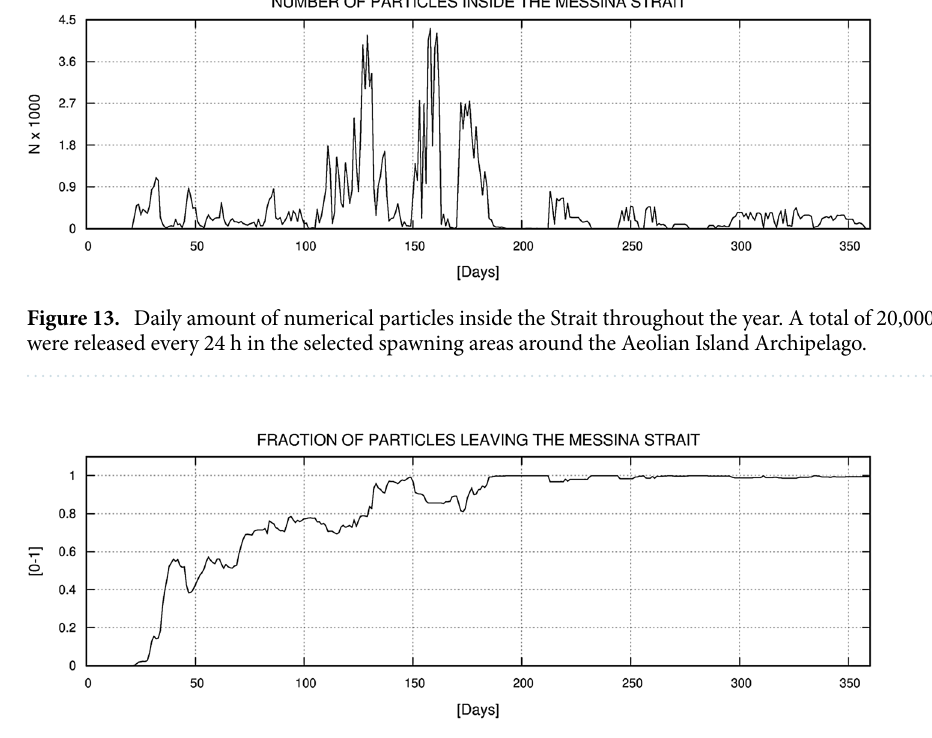
Figure 14. Evaluation of the retention efficiency of the Strait: ratio between the amount of numerical particles leaving the Strait to the Tyrrhenian Sea and the amount of numerical particles entering in the